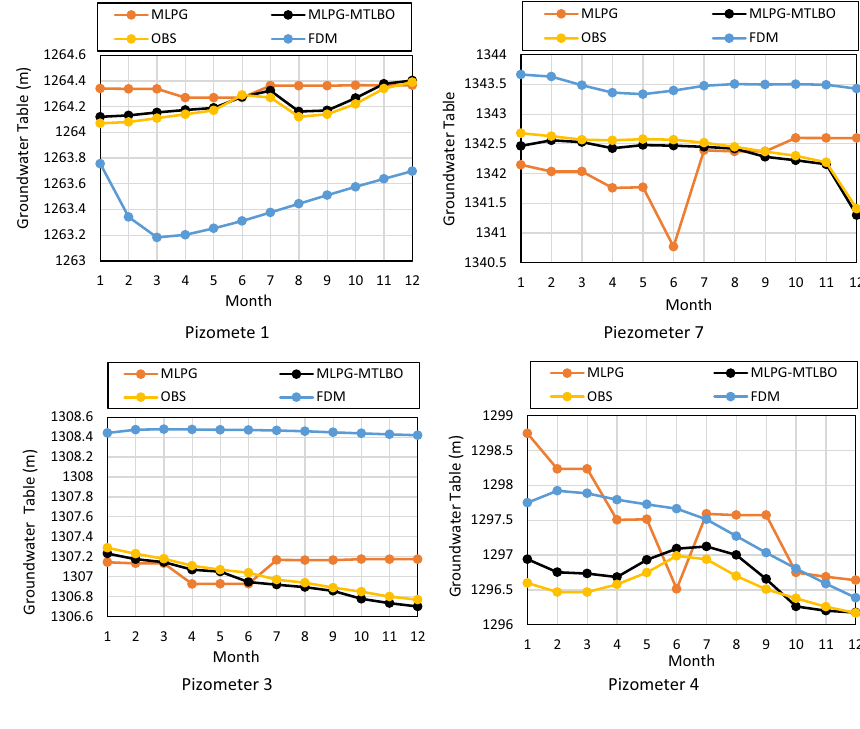
Fig. 7 Comparison of different models in simulation